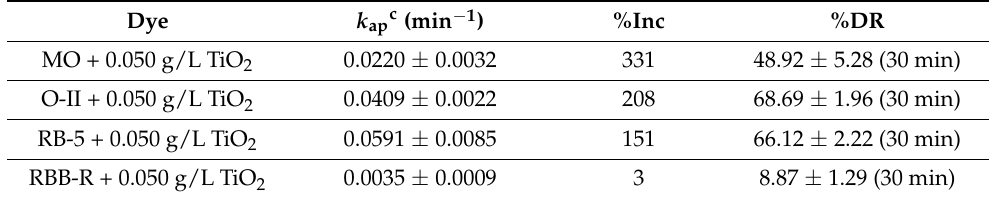
Table 4. Apparent rate constant, percentage of the rate constant when the catalyst is present, and percentage of dye removal of the UV + TiO 2 AOP of dyes (the standard deviations of at least three independent repetitions are shown). In parentheses, the reaction time necessary to achieve the percentage of dye removal is shown. The fitting of the integrated first-order kinetics resulted in R 2 >